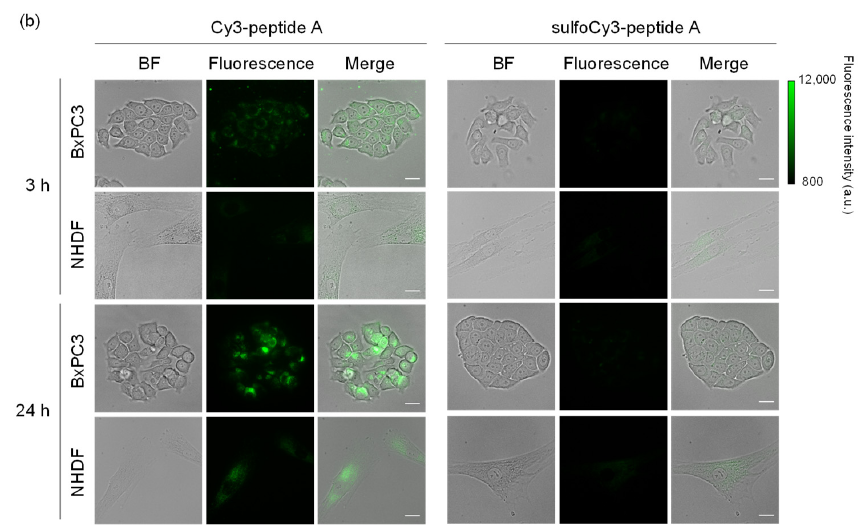
Figure 2. Fluorescence images of BxPC3 and NHDF cells treated with dye-peptide A. ( a ) Cy5/sulfoCy5-peptide A, ( b ) Cy3/sulfoCy3-peptide A. Cells were incubated with 0.1 µ M dye-peptide A at 37 ◦ C for 3 or 24 h before imaging. Bright field (BF), Cy5/Cy3 fluorescence, and merge images are shown. Scale bar: 10 µ m.